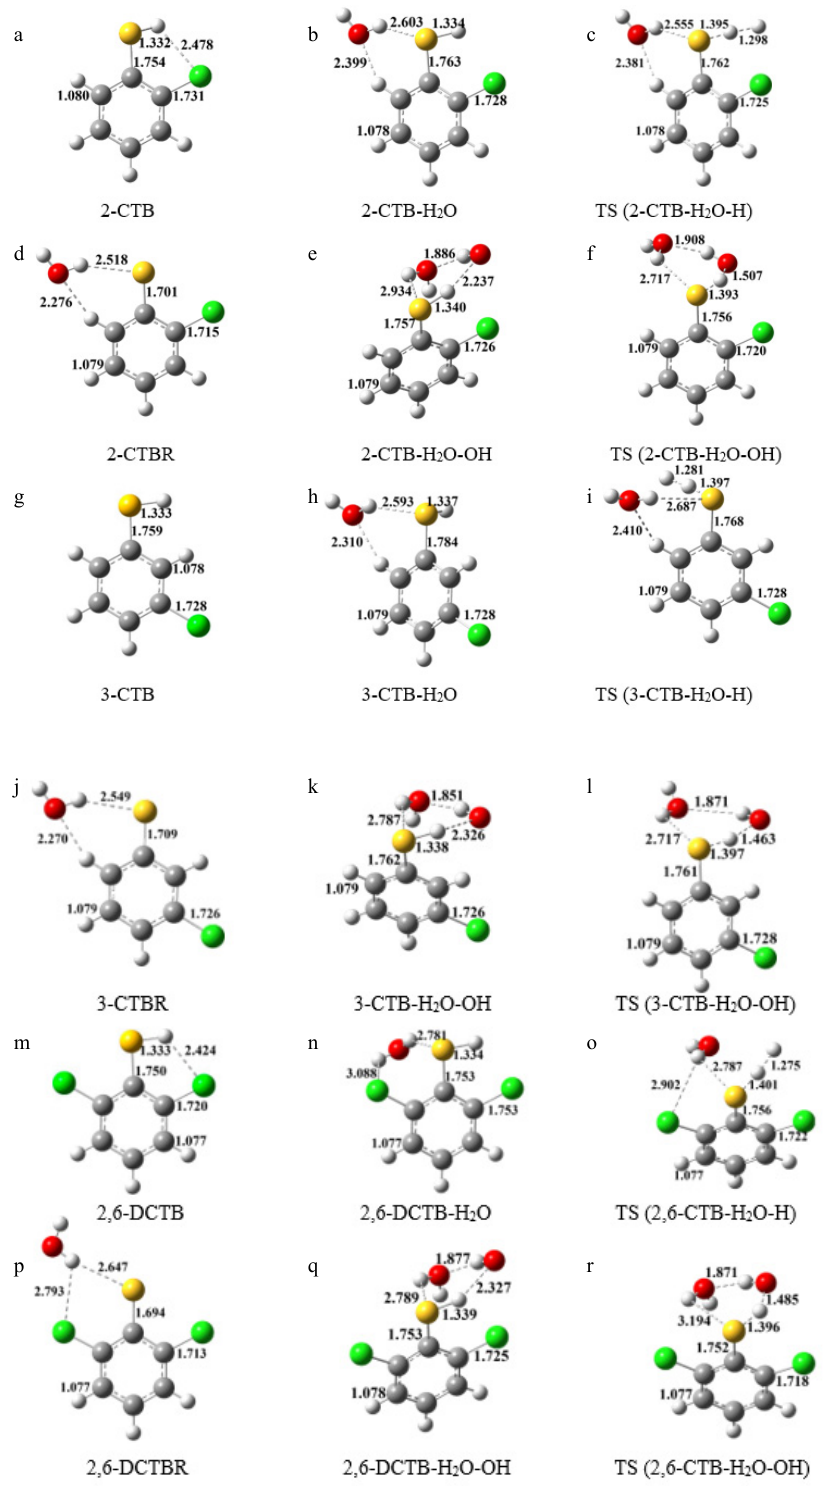
Figure 1. Configuration of reactants, transition states, pre-reactive intermediates, and products for H abstraction from 2-CTB, 3-CTB, and 2,6-DCTB by H and · OH in hydrated cases (denoted by ( a – r ), respectively). Distances are in angstroms. Gray sphere, C; White sphere, H; Red sphere, O; Yellow sphere, S; Green sphere, Cl.